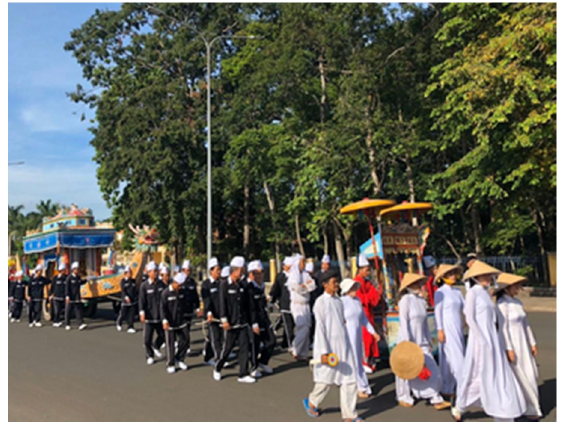
Figure 12. On the morning of the third day, on the way to the cemetery, Tây Ninh, 2 July 2018 (© Shao Zhu Shuai).